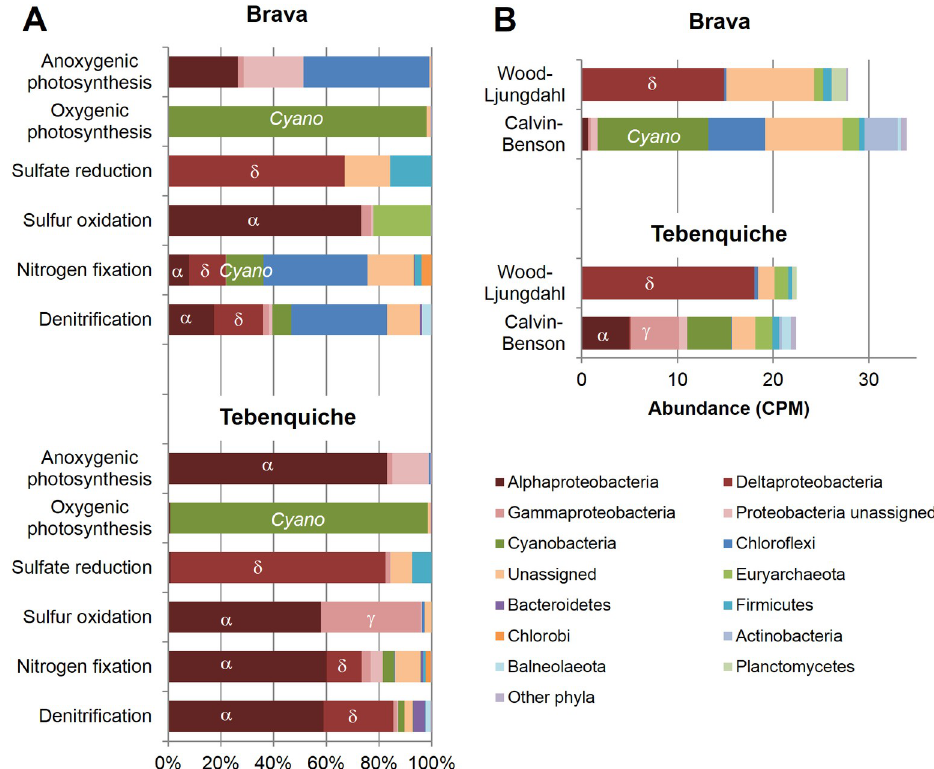
Fig 3. Functional analysis of biogeochemical cycles, based on KO markers. (A) Relative abundance and taxonomic affiliation of markers associated to each process. (B) Abundance (in counts per million–CPM) and taxonomic affiliation of markers for different carbon fixation pathways. Additional markers analyzed had very low abundances or provided unreliable results (see text).